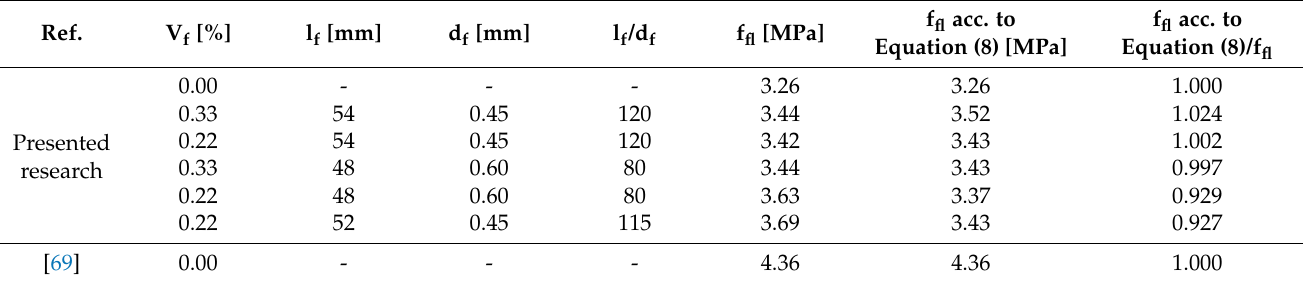
Table 10. Comparison of the results of the presented research and the results from selected literature positions with the results obtained for the empirical formula proposed by the authors for the flexural tensile strength f fl .